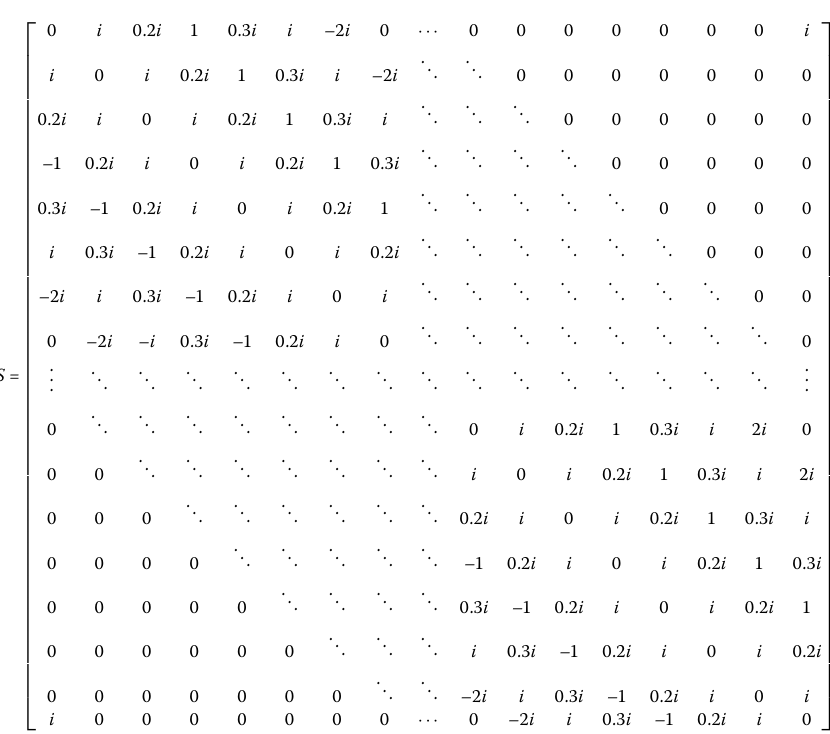
Example  Furthermore, we consider the general skew-Hermitian matrix S as a   ×   seven diagonal matrix in the complex field for the shifted skew-Hermitian linear system, and the simulations are provided to show the computational cost for the α -SSS. We